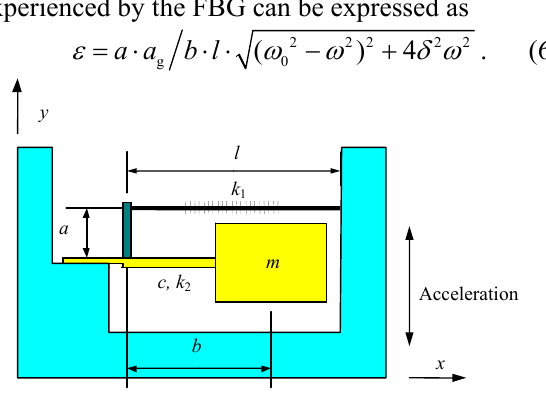
Fig. 2 Schematic of FBG-based micro-seismic sensor. Fig. 3 Photograph of FBG-based micro-seismic sensor.